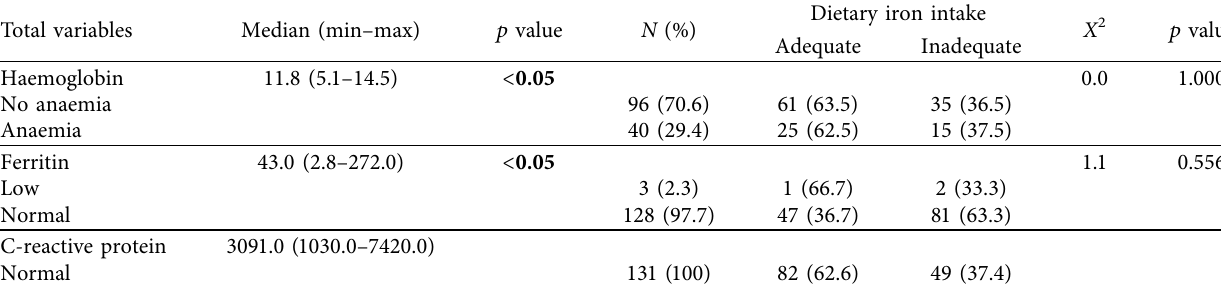
Table 3: Biochemical markers and dietary iron intake.